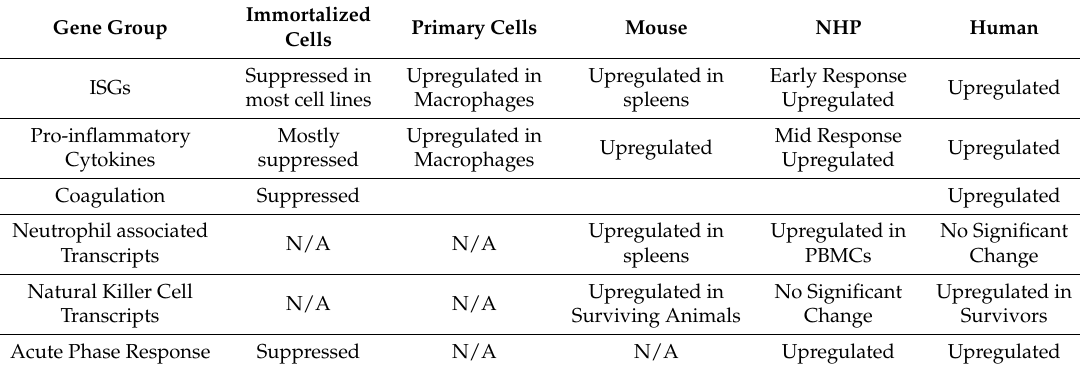
Table 1. Comparison of general gene transcription across the various